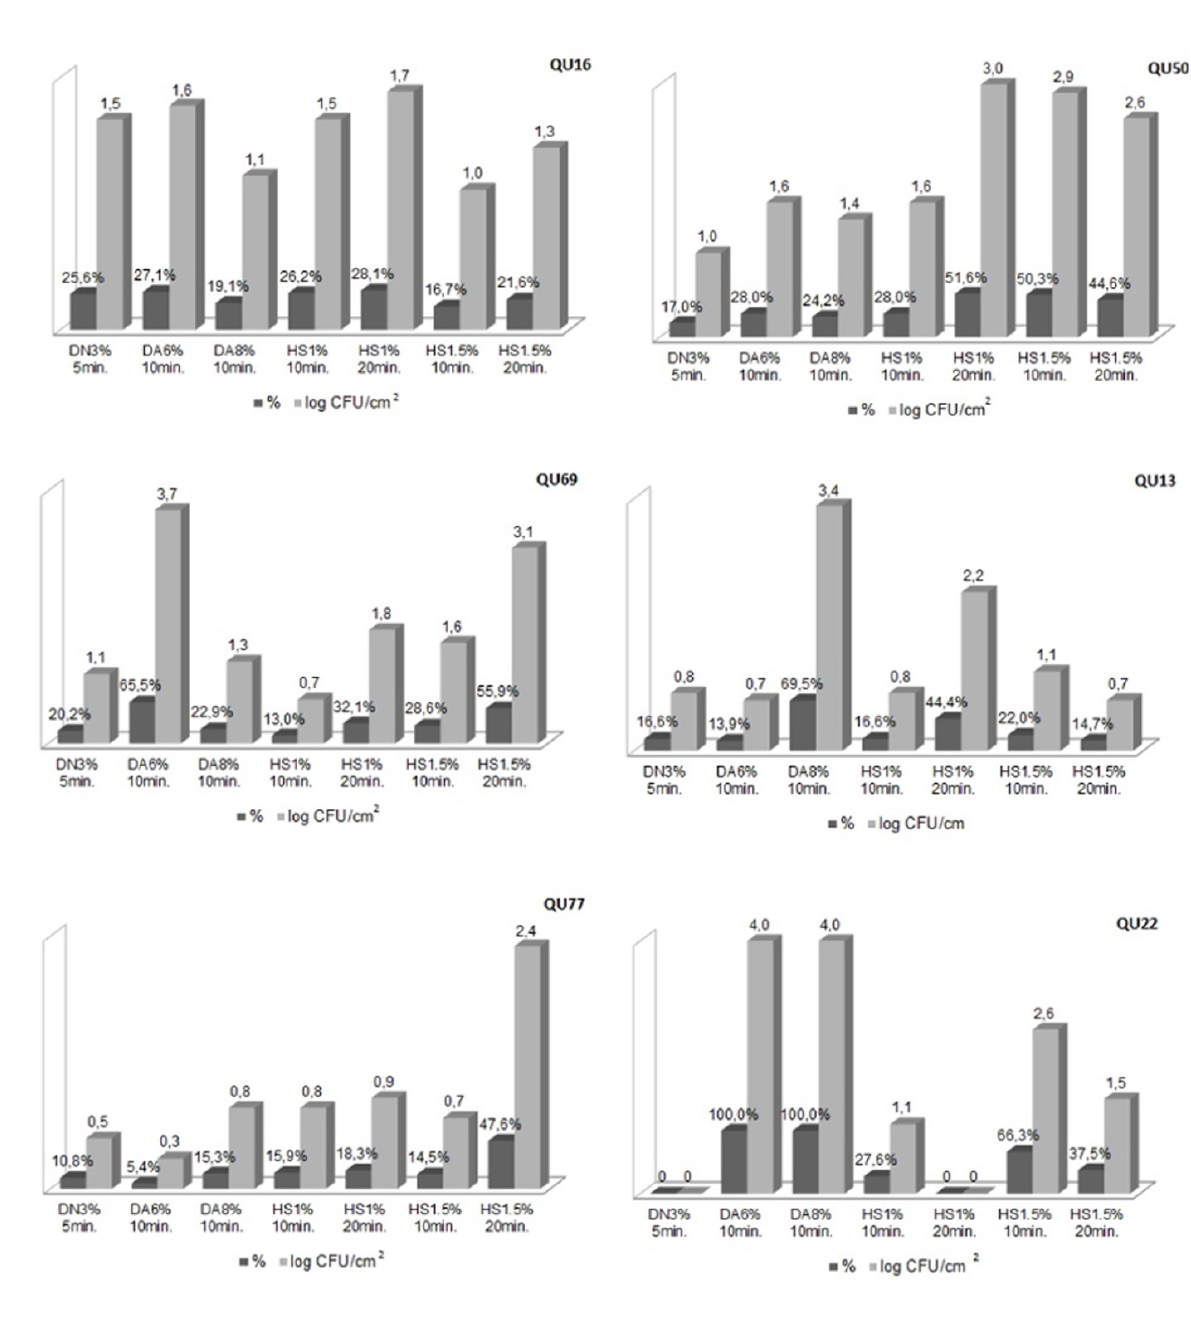
Figure 3. Survival of (a) QU16, (b) QU50, (c) QU69, (d) QU13, (e) QU77, (f) QU22 Yarrowia lipolytica isolates (log CFU/ cm 2 ) on the hose coupon before and after application of sanitation product (DN 3%) % mild detergent 03-05 min, (DA6 %) and (DA8 %) alkaline detergent and 8 % - 6 % - 10 min (HS1 %) sodium hypochlorite 1 % - 10 to 20 min and (HS 1,5 %) sodium hypochlorite 1.5 % - and 10-20